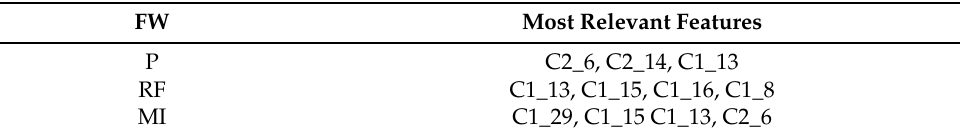
Table 5. Most relevant features according to each FW method.